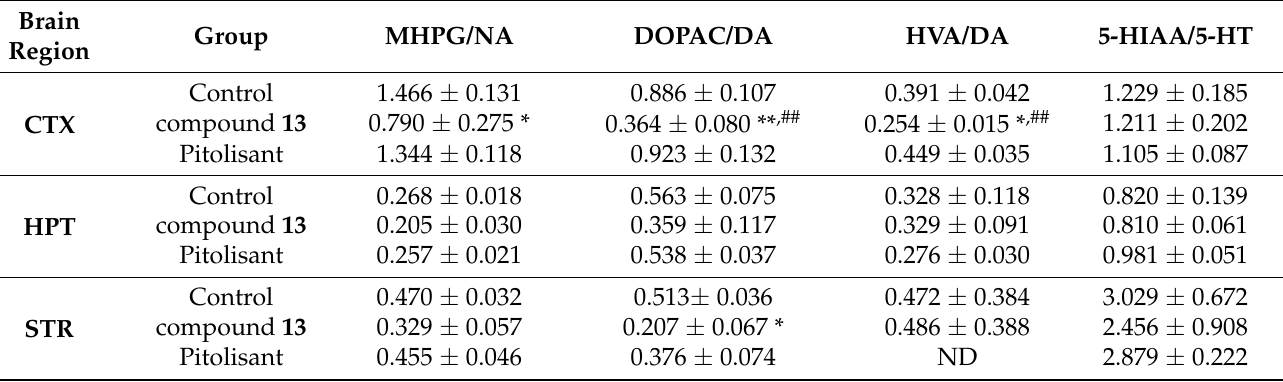
Table 8. Ratio a of monoamines and their metabolites in different brain areas in rats—the effect of sub-chronic treatment with compound 13 and